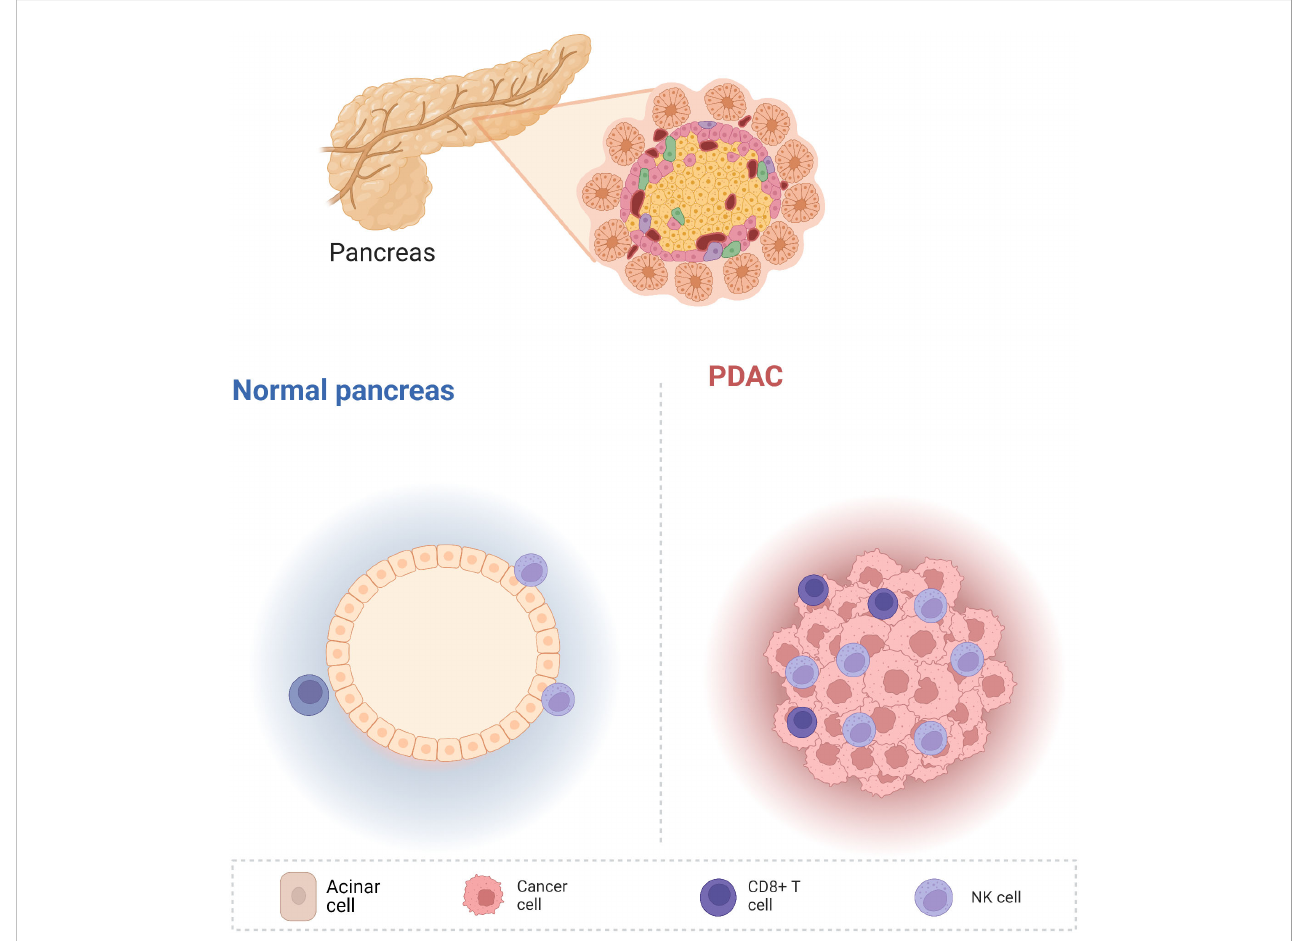
FIGURE 1 Compared with other digestive tract organs, the non-cancerous pancreas is relatively clean and contains very few immune cells. Nevertheless, pancreatic cancer development is accompanied by the in fi ltration of numerous immune cells, including innate and adaptive immune